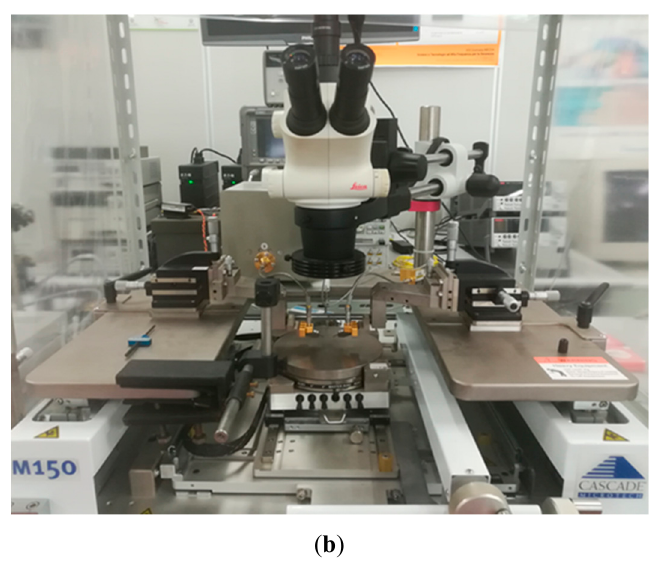
Figure 2. ( a ) Block diagram and ( b ) picture of the measurement system.